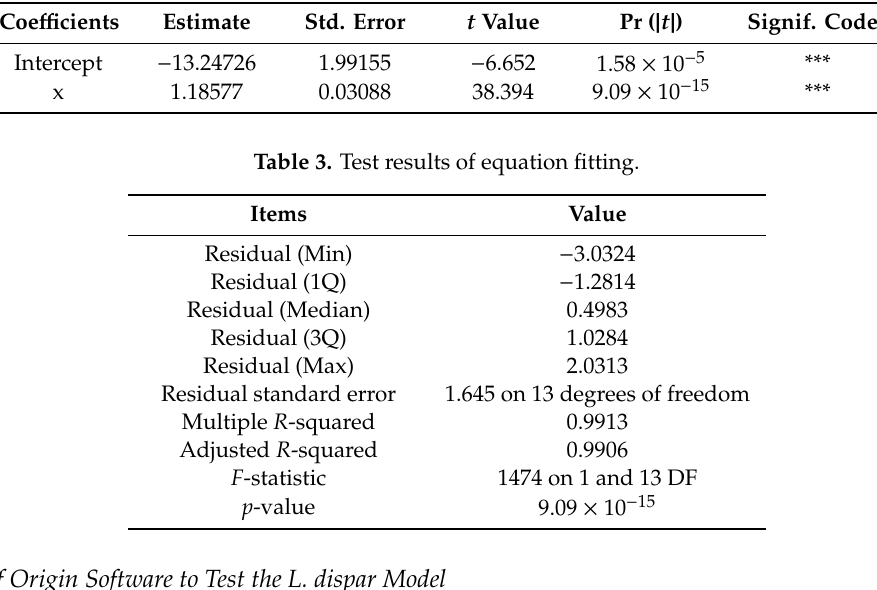
Table 2. The calculation results of parameter estimation of L. dispar equation (lm (formula = y ~ 1 + x), where x is the δ 2 H value of L. dispar and y is the δ 2 H value in precipitation). *** represents the highest level of significance.